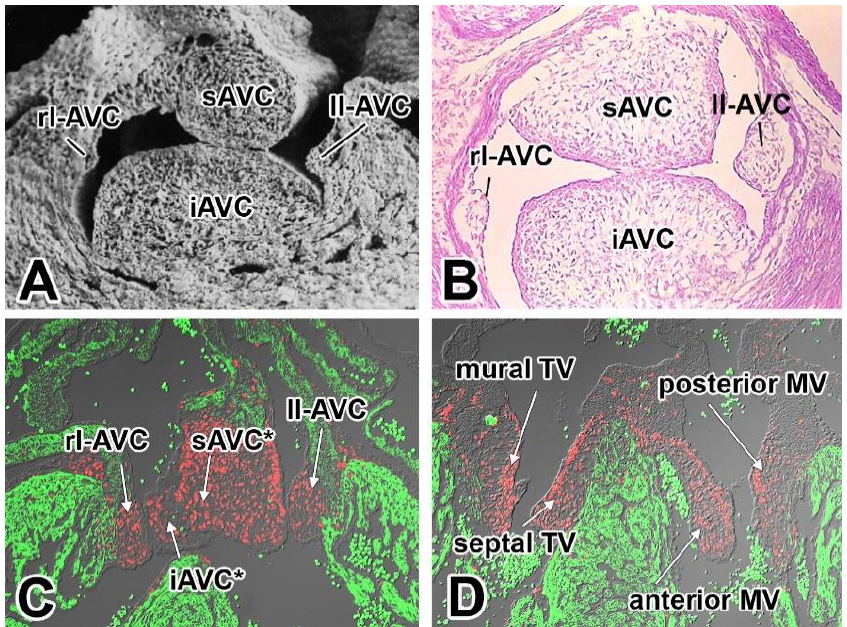
Figure 2. The AV cushions and their derivatives. A scanning electron microscopical ( A ) image and ( B ) a histological section show the major and lateral AV cushions at 13 ED. Immunofluorescently- stained sections of a 13.5 ED ( C ) and a 15 ED ( D ) heart show how the respective cushions contribute to the AV valve leaflets as the heart develops. The sections were stained for myosin heavy chain (green) and SOX9 (red). The asterisks in ( C ) are added to indicate that after the major cushions have fused, it is no longer possible to say with certainty whether a particular cell is derived from the iAVC or sAVC. Abbreviations: iAVC, inferior AV cushion; sAVC, superior AV cushion; ll-AVC, left lateral AV cushion; rl-AVC, right lateral AV cushion, MV, mitral valve; TV, tricuspid valve.